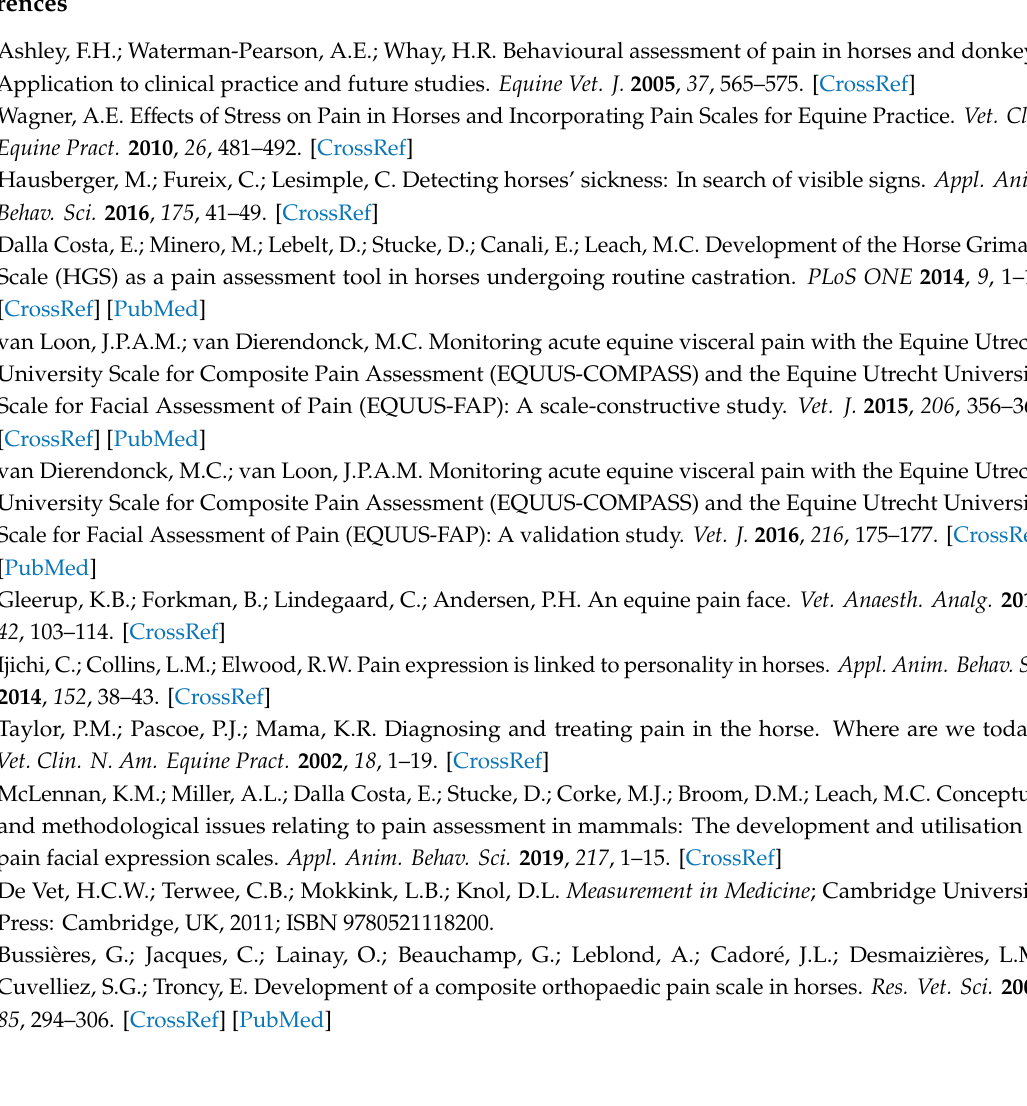
Table S1: Mean ( ± SD) scores for each scale item, File S2: Dataset in an Excel book used for data